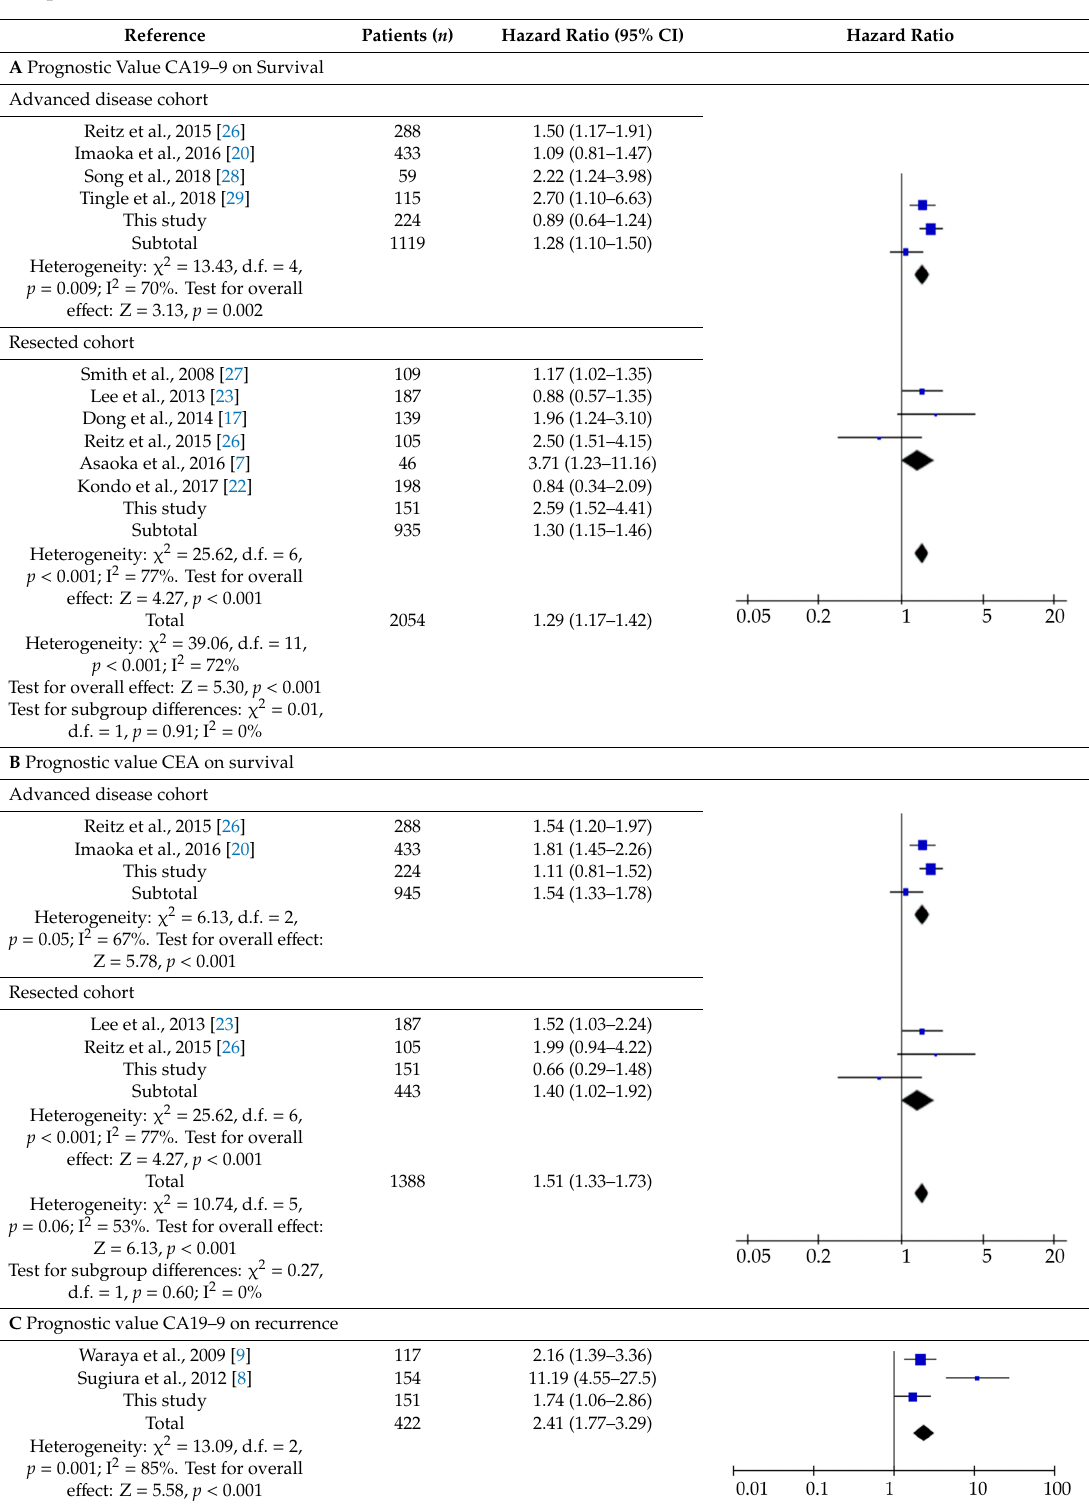
Table 4. Forest plots of prognostic value of ( A ) CA19-9 and ( B ) CEA on overall survival in PDAC patients, including subgroup analysis. The prognostic value of CA19-9 on recurrence in resected PDAC patients was also shown ( C